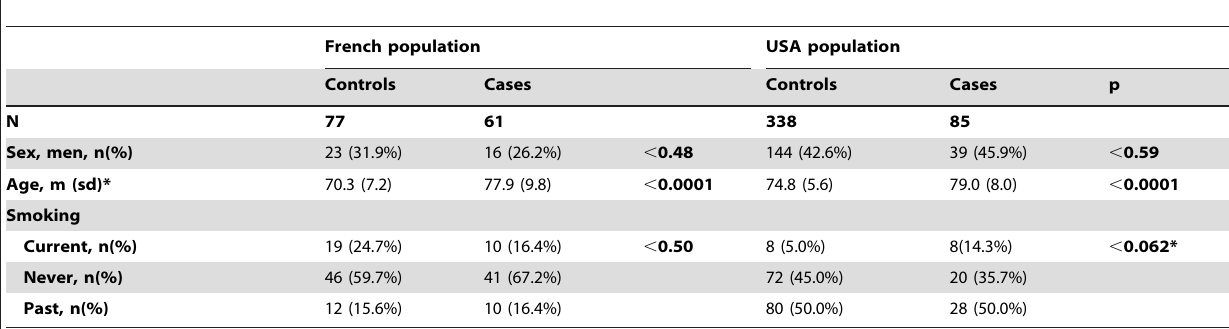
Table 3. Non-genetic characteristics of the French and North American populations with no risk alleles for CFH and ARMS2 .